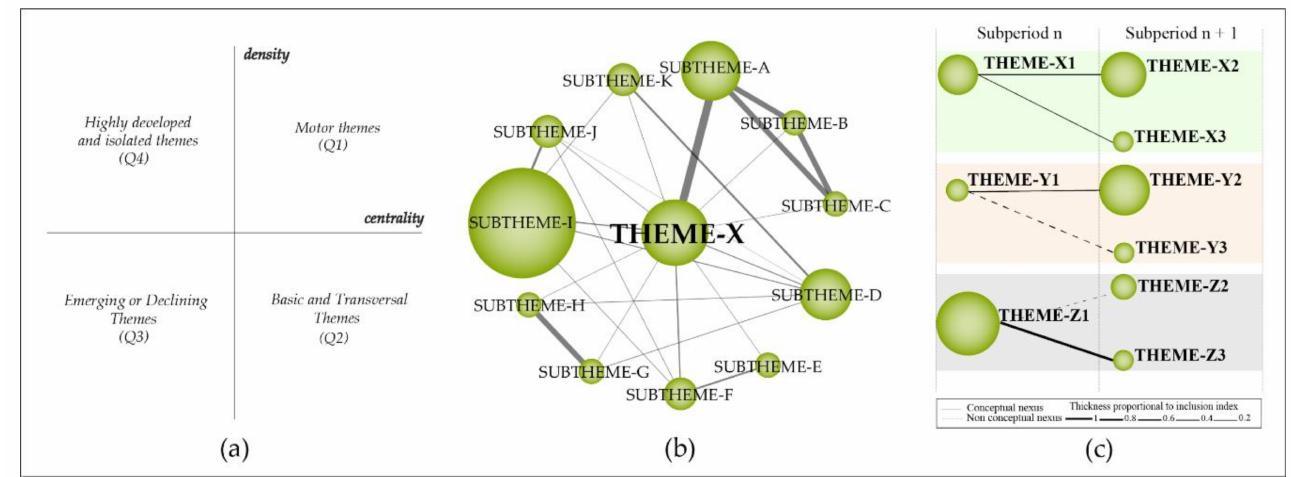
Figure 1. Strategic diagram ( a ); thematic network structure ( b ); thematic evolution structure ( c